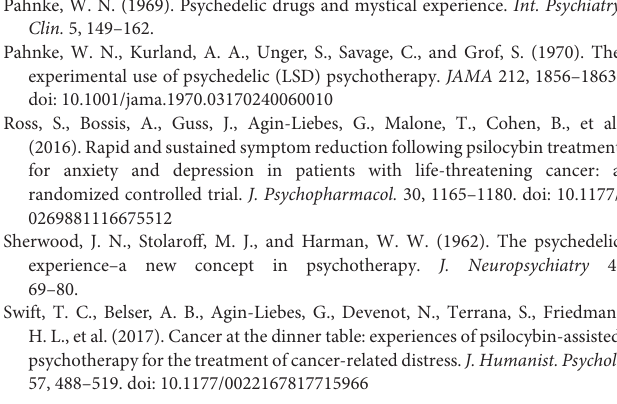
FIGURE S1 | Overview of study design. Treatment components by week are depicted. FIGURE S2 | Quantitative data from the four cases presented. Scores on the Death Anxiety Scale (DAS), the Hopelessness and Anxiety Inventory (HAI), the Purpose in Life (PIL) questionnaire, the Death Transcendence Scale (DTS), the Functional Assessment of Chronic Illness Therapy-Spiritual Well-Being (FACIT-SWB) and the Spiritual Transcendence Scale (STS) are shown here for each participant over